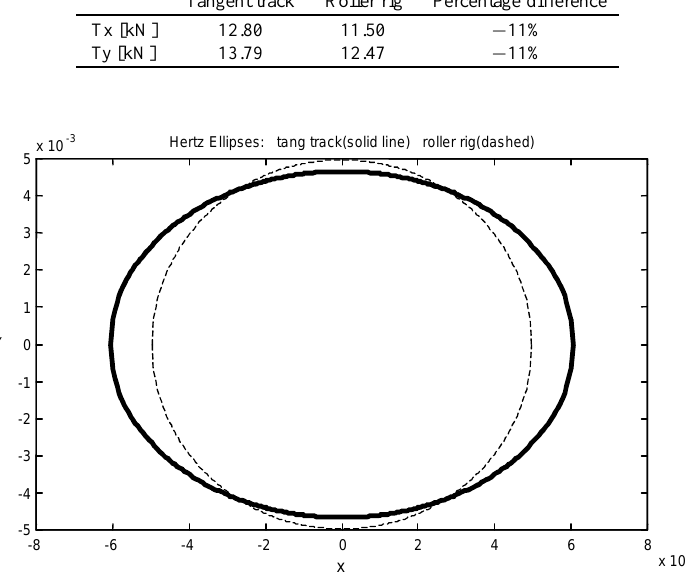
Fig. 7. Contact Ellipses determined with the contribution of the bogie mass.